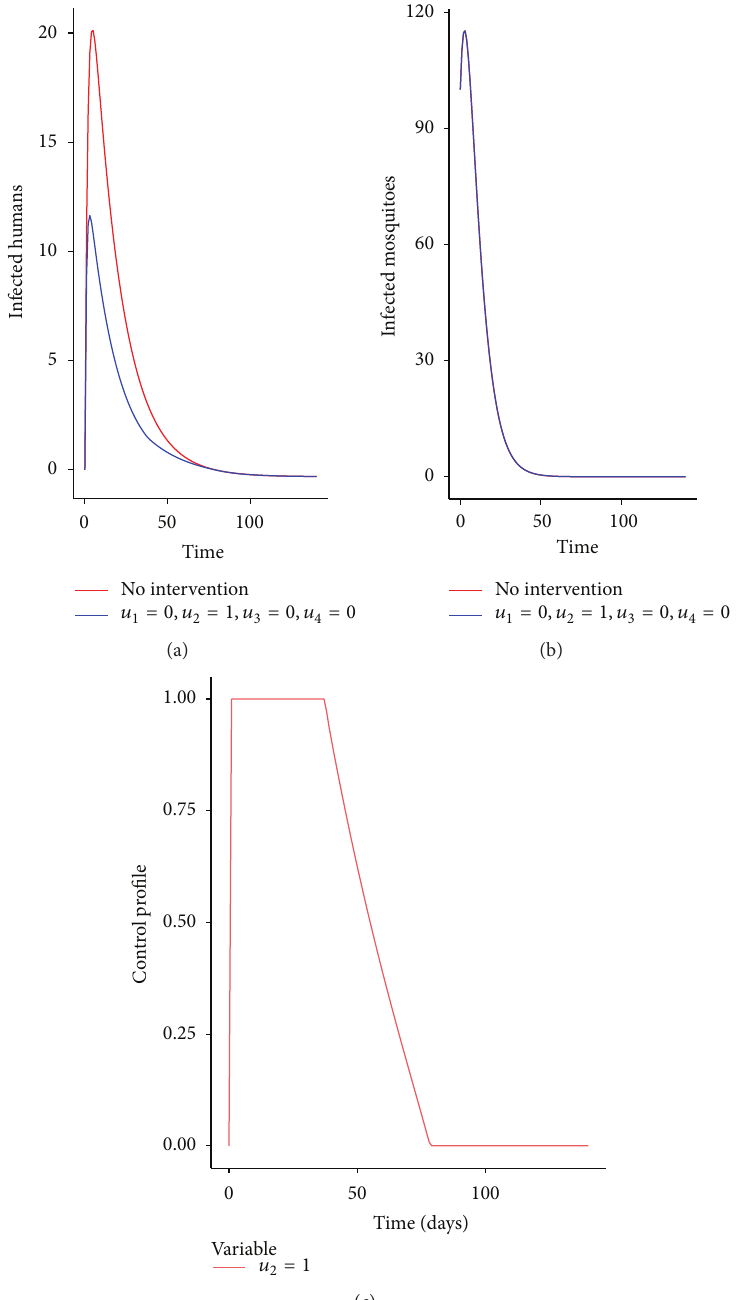
Figure 3: Simulations of the model showing the effect of treatment on the spread of malaria for the endemic setting.